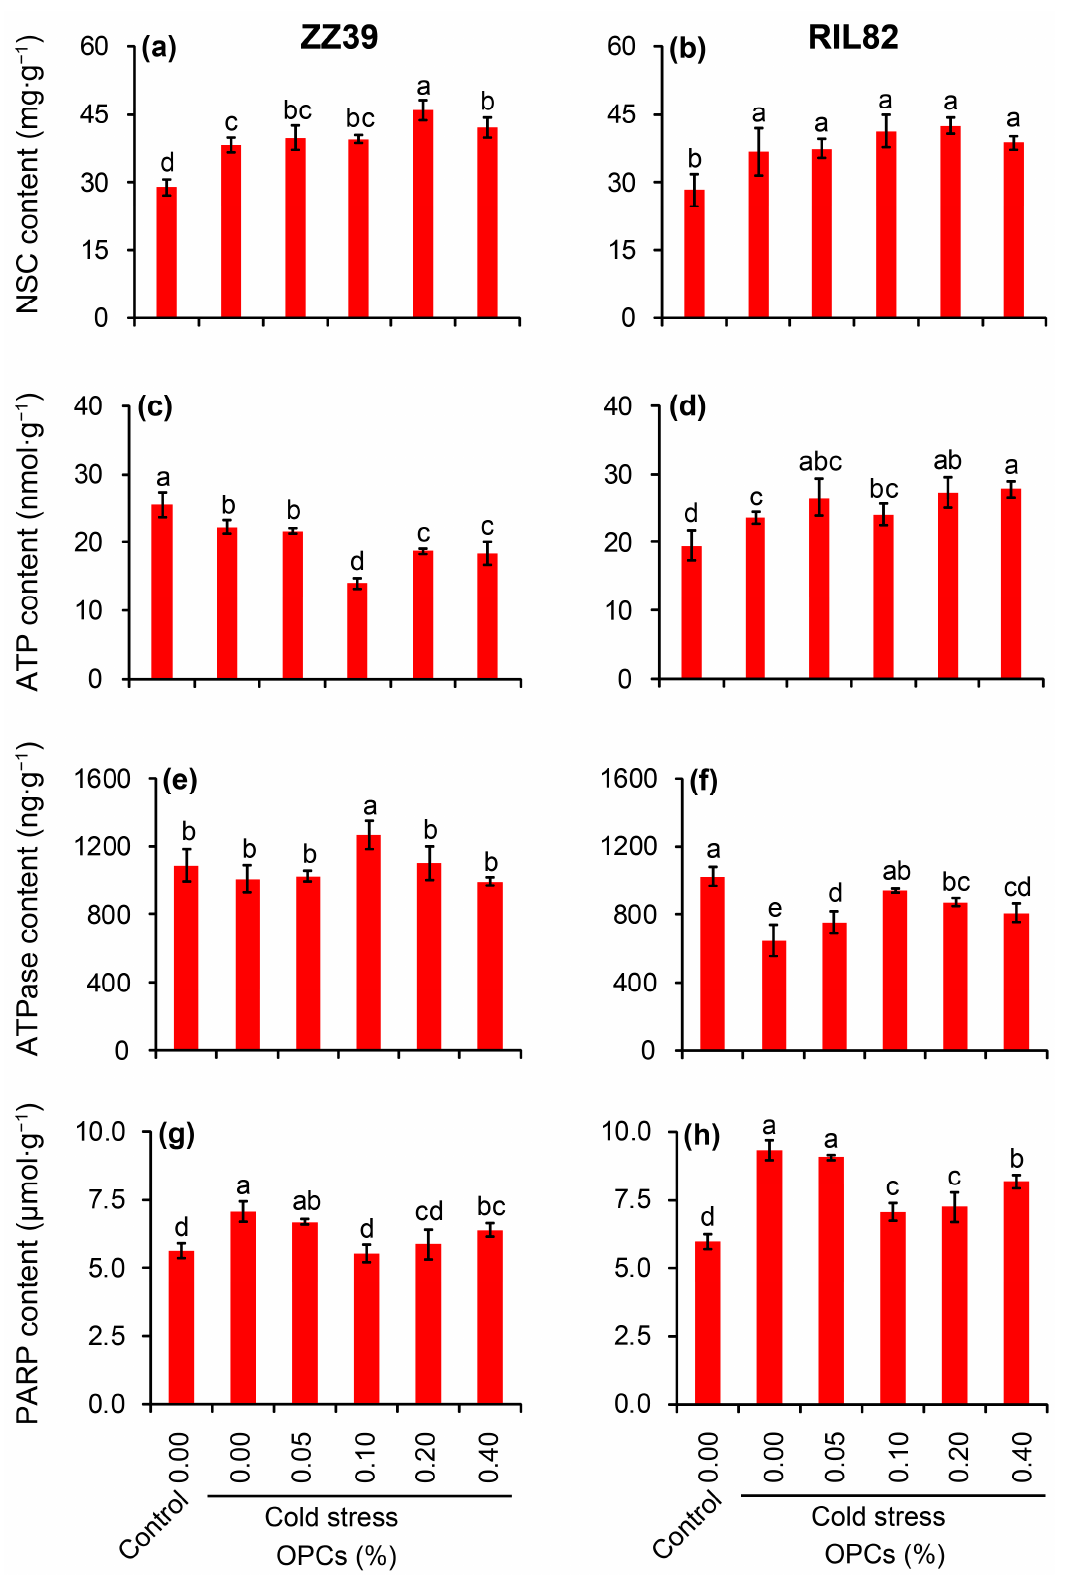
Figure 6. Effect of OPCs on NSC content, ATP metabolism, and PARP content of rice leaves under cold stress. ( a , b ), NSC content; ( c , d ), ATP content; ( e , f ), ATPase content; ( g , h ), PARP content. OPCs, oligomeric proanthocyanidins; NSC, non-structural carbohydrates; PARP, poly (ADP-ribose) polymerase. Vertical bars denote standard deviations ( n = 3). Different letters indicate significant differences among the control and cold stress treatments within a genotype by two-way analysis of variance (temperature and treatment) ( p <